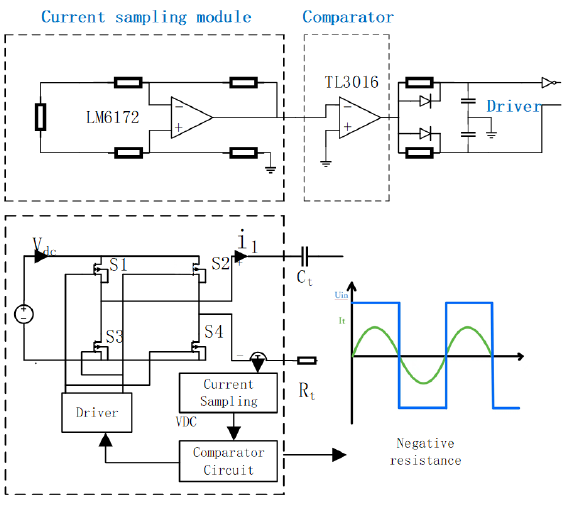
Figure 11. Circuit structure diagram and output waveform of negative